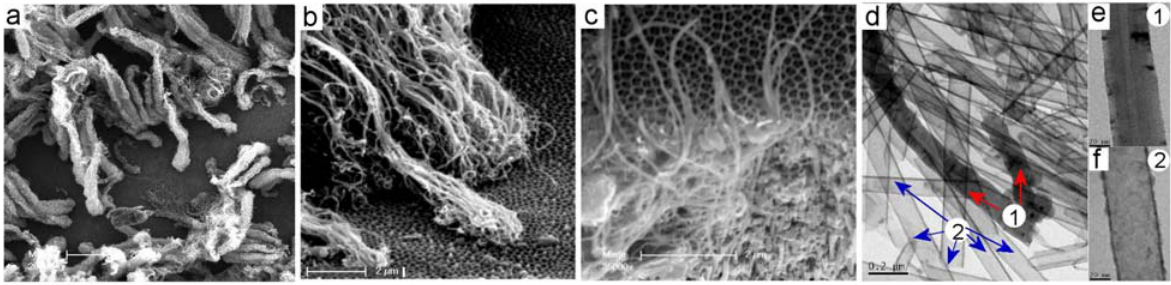
Figure 4. (a-b) Overgrowth of CNT on the top of PA membranes caused by catalytic reaction on the PA surface; (c) overgrowth of CNT caused by ferrocene catalytic reaction from the pores; (d) TEM image of CNT prepared after liberation of nanotubes from template showing two different types of CNT (1) iron catalyst induced growth on surface and (2) CNT grown inside of pore; (e) high resolution TEM image of catalyst growth CNT; and (f) pore growth